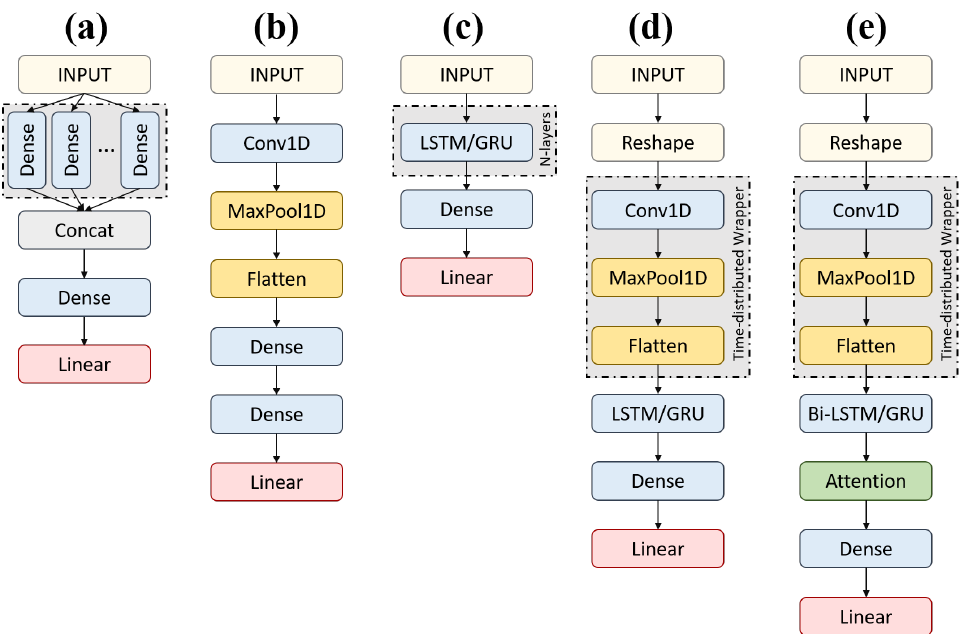
Figure 4. Brief architectural details for models, ( a ) MLP; ( b ) CNN; ( c ) LSTM and GRU-based models; ( d ) CNN-RNN hybrid models; ( e ) CNN-RNN hybrid models with bidirectional and Attention mecha-